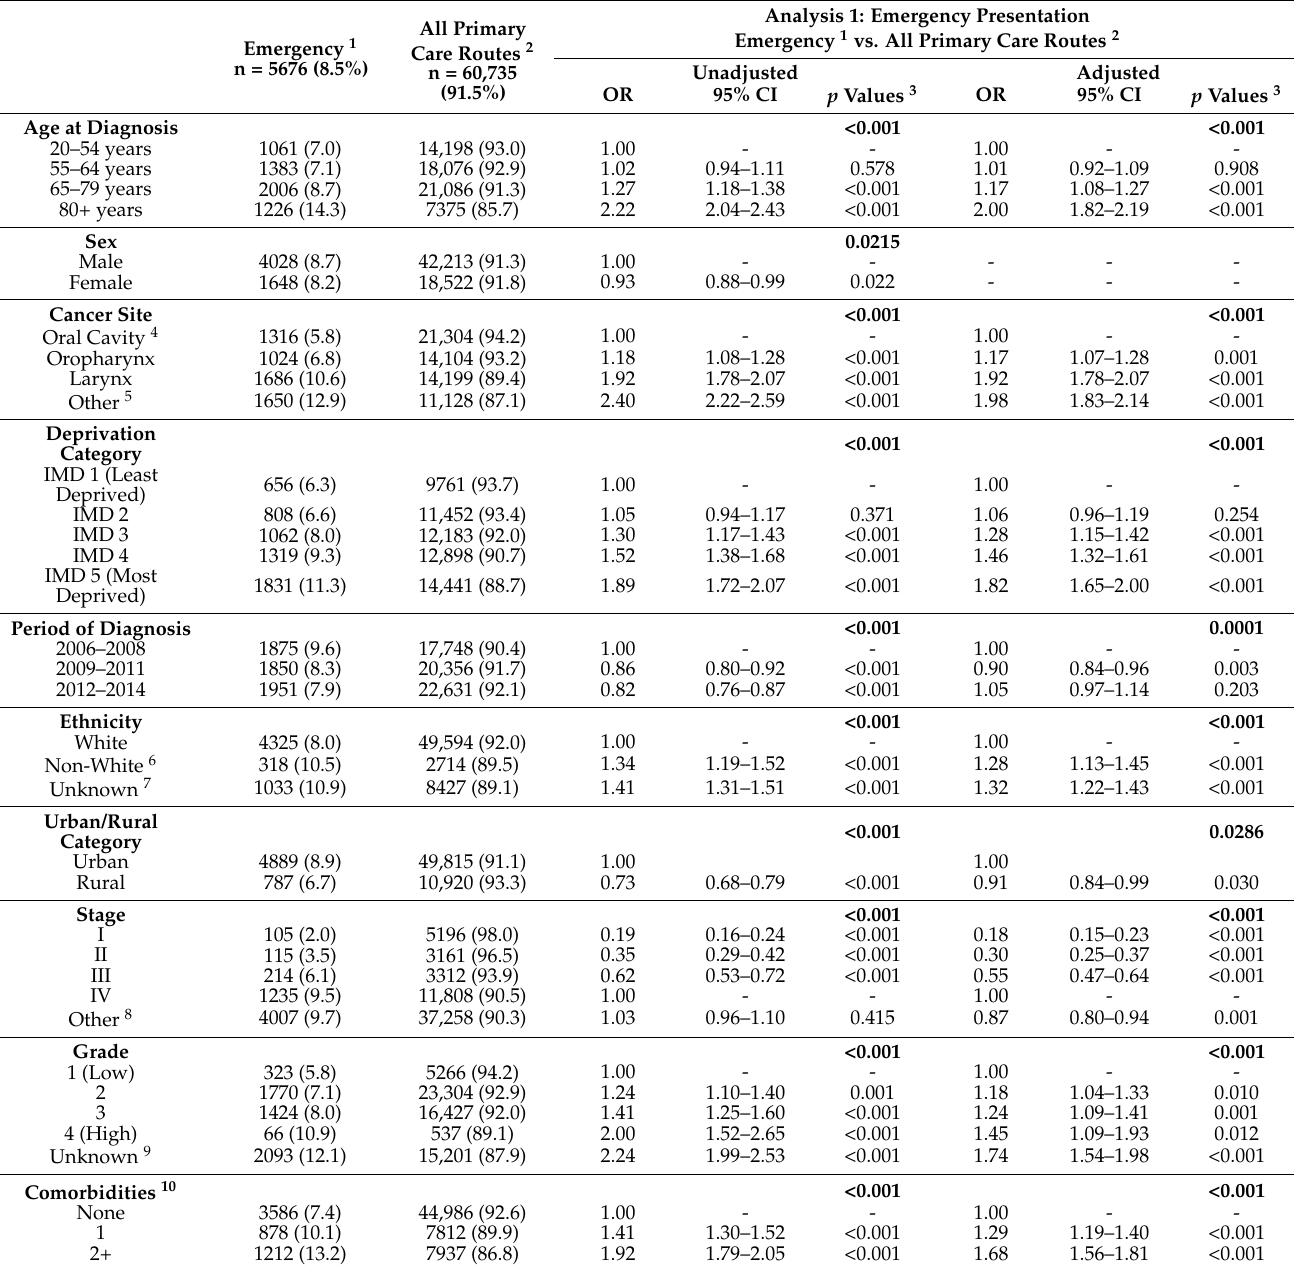
Table 2. Likelihood (OR, 95% CI and p values) from logistic regression of emergency versus all primary care routes by socio-demographic and clinical characteristics for Analysis 1 (n =